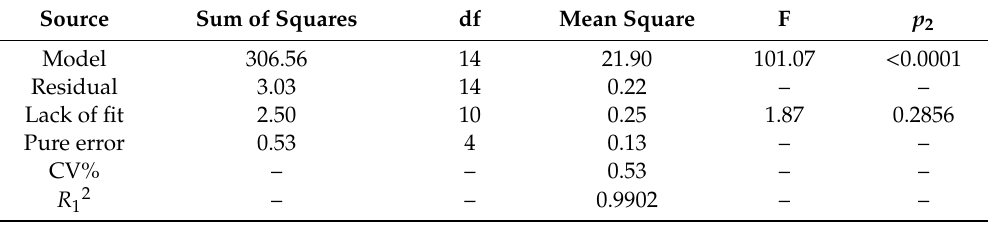
Table 4. The variance analysis of the fitted quadratic polynomial prediction model of p